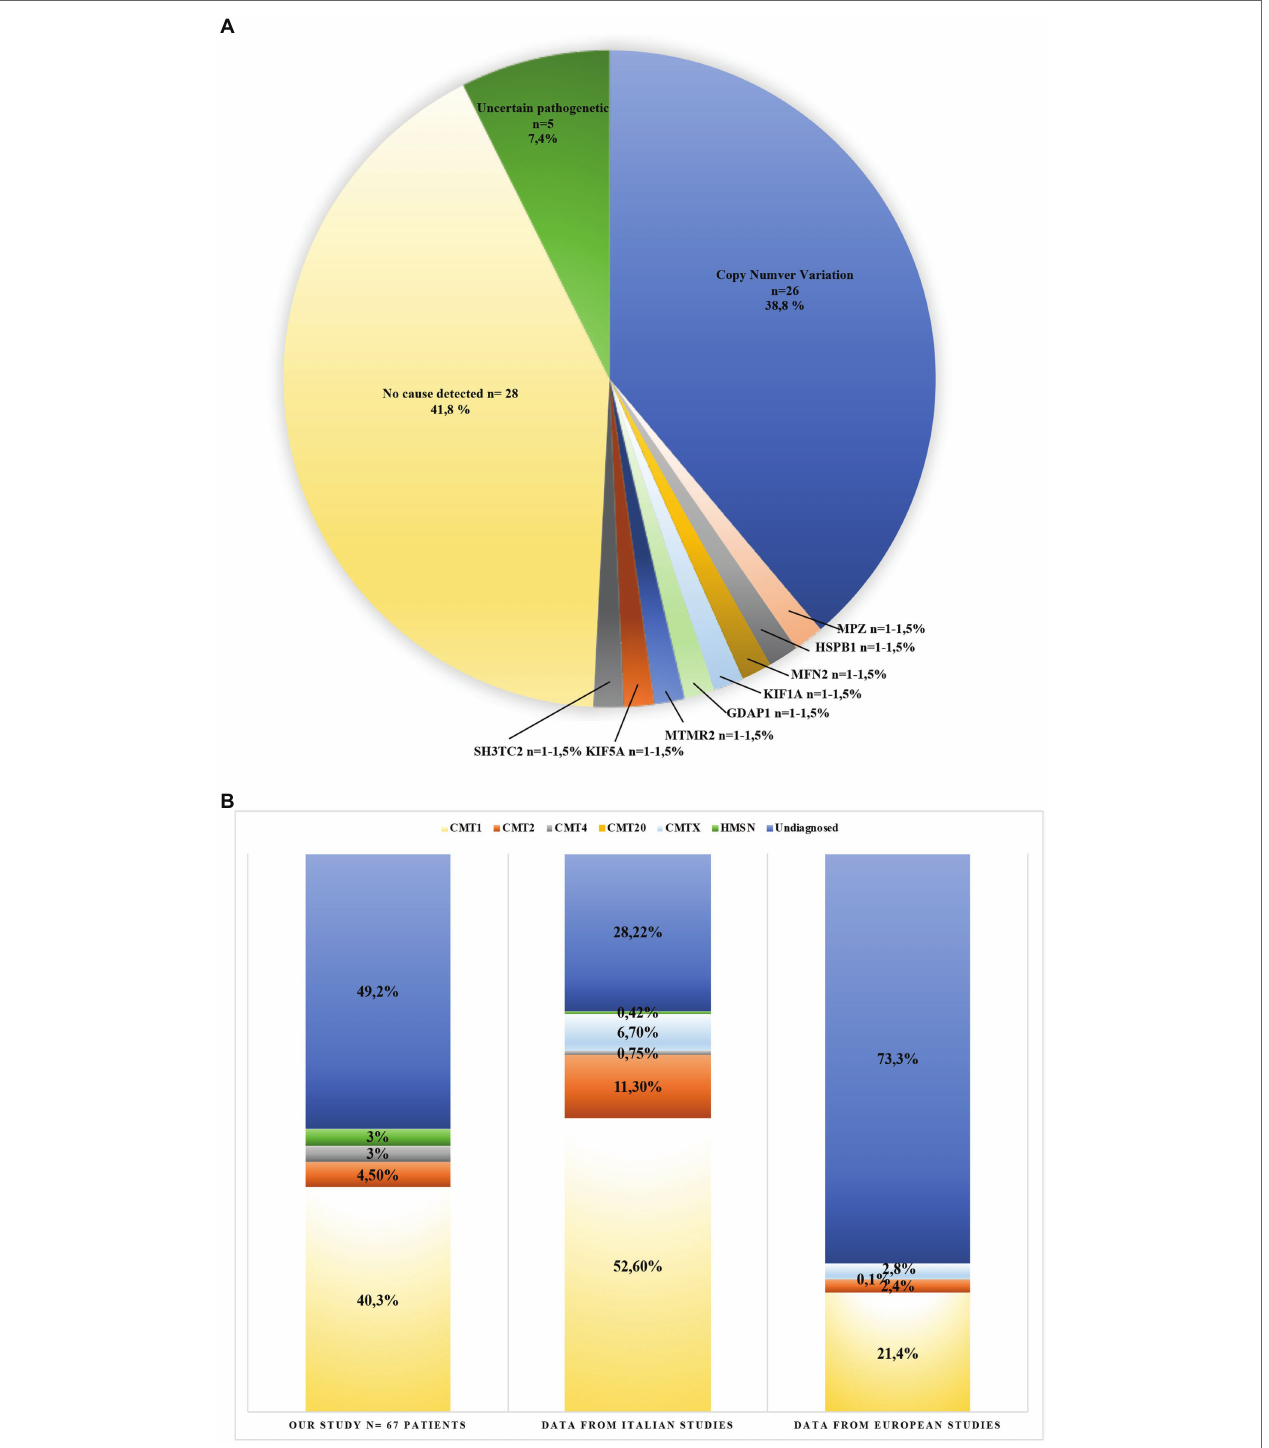
FIGURE 2 | Genotype and phenotype of Charcot-Marie-Tooth (CMT) patients from this study (A) , and CMT patients reviewed from the literature (B) . (A) Variants identified in 67 CMT patients (blue: copy number variation 38.8%; orange: MPZ mutation 1.5%; gray: HSPB1 mutation 1.5%; light yellow: MFN2 mutation 1.5%; light blue: KIF1A mutation 1.5%; green: GAPD1 mutation 1.5%; dark blue: MTMR2 mutation 1.5%; brown: KIF5A mutation 1.5%; dark gray: SH3TC2 mutation 1.5%; yellow: no cause detected 41.8%; and dark green: uncertain pathogenetic 7.4%). (B) This graphic compares detection yield in CMT phenotypes obtained from the literature. (light yellow: CMT1; orange: CMT2; gray: CMT4; light blue: CMTX; green: HMSN; and blue: undiagnosed). Bar 1: data obtained in this study; Bar 2: data obtained from three Italian studies; and Bar 3: data obtained from 20 European studies (see Supplementary Material